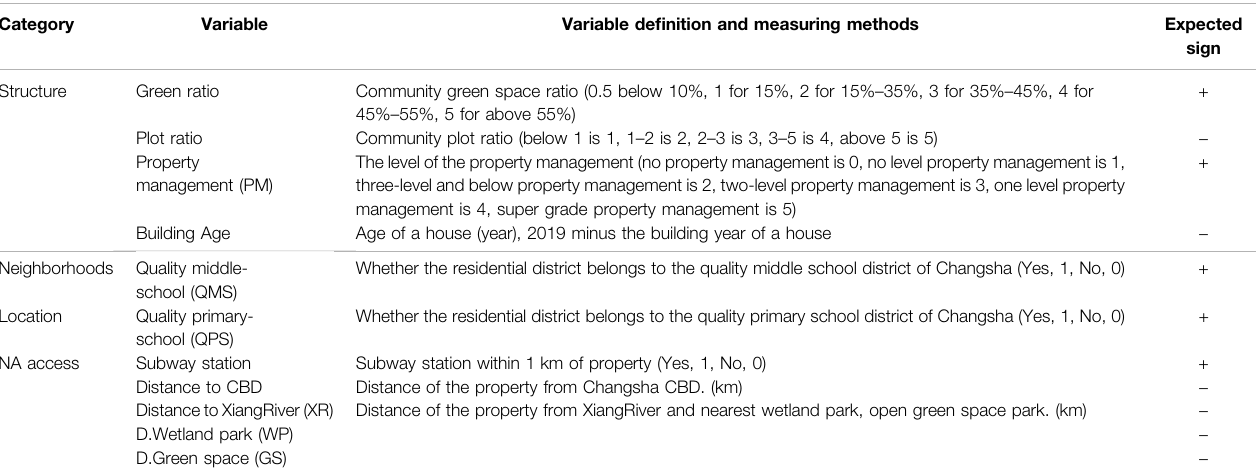
TABLE 3 | Variables of residential price differentiation in